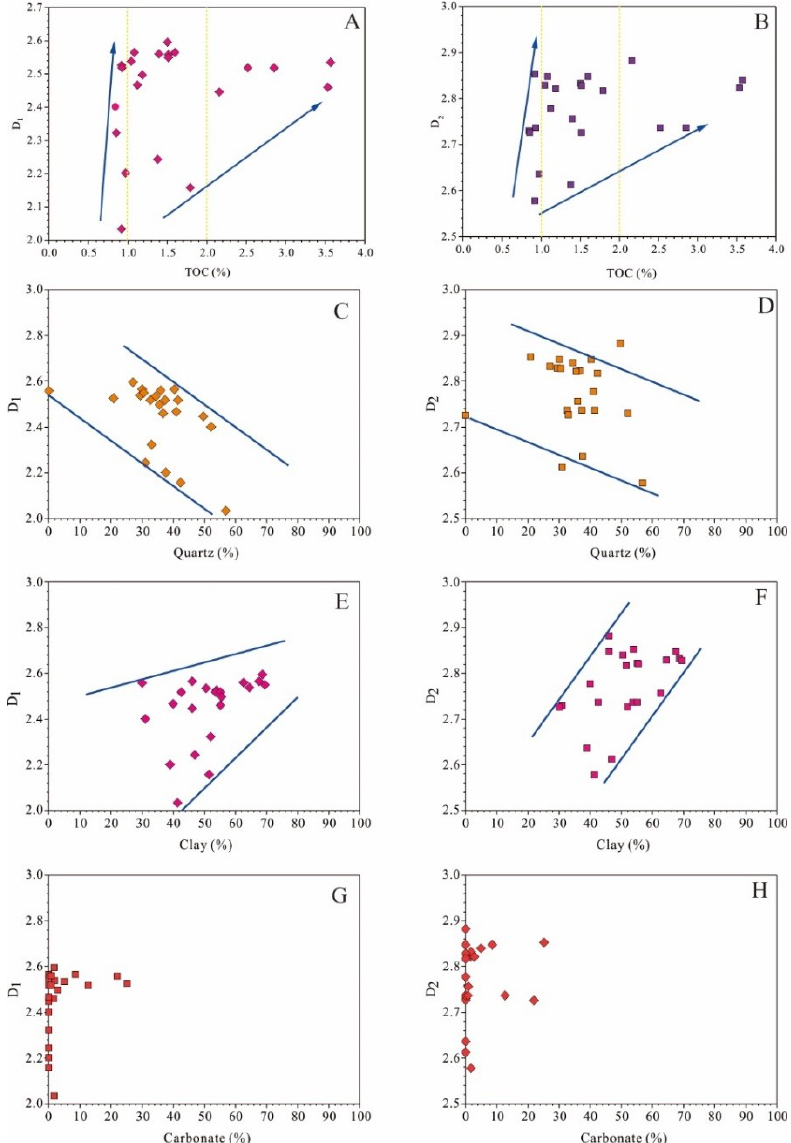
Figure 12. Relationship between fractal dimensions (D1, D2) and OM and inorganic mineral compositions: (A) D1 versus TOC content; (B) D2 versus TOC content; (C) D1 versus quartz content; (D) D2 versus quartz content; (E) D1 versus clay mineral content; (F) D2 versus clay mineral content; (G) D1 versus carbonate mineral content; (H) D2 versus carbonate mineral content.